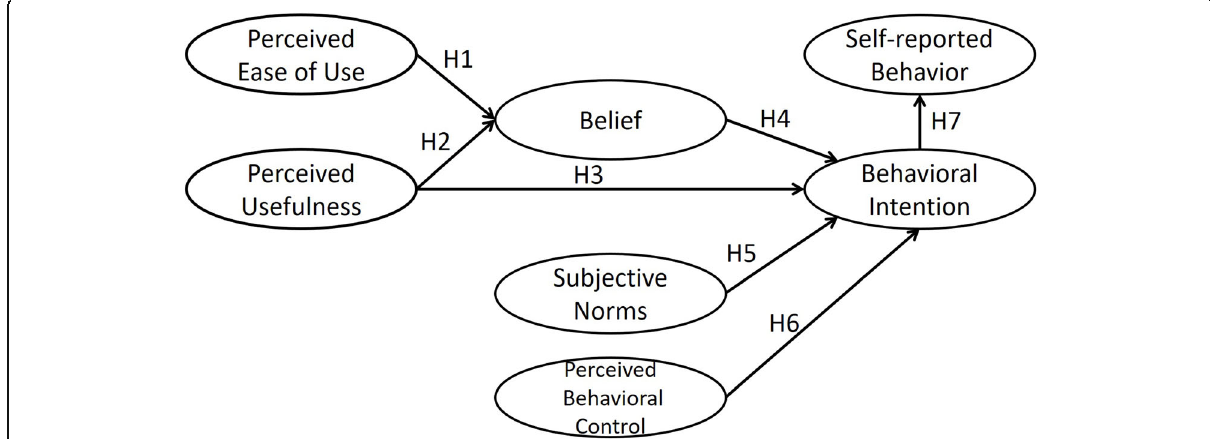
Fig. 2 Proposed model of technology teachers ’ behavioral intentions